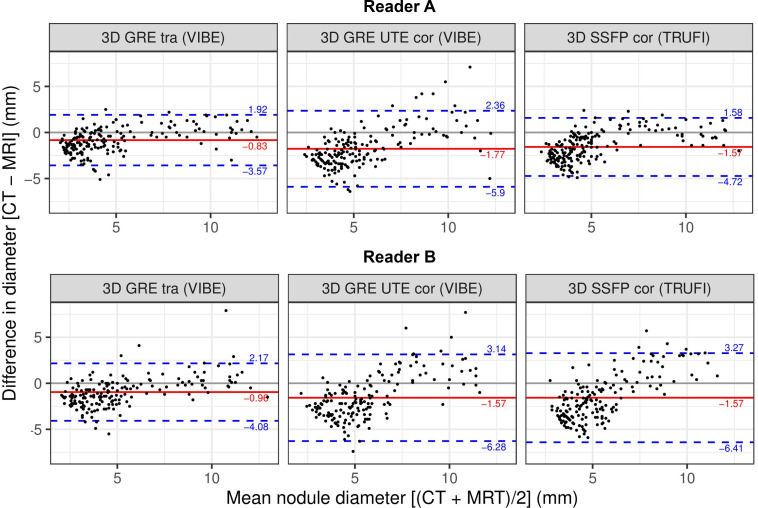
Bland-Altman-plot showing the differences between the nodule size measurements using MRI vs. CT for each of the tested sequences and each reader.The red lines indicate the bias (mean difference between CT and MR measurements), and the dashed blue lines indicate the 95% confidence interval (±1.96 × standard deviation).